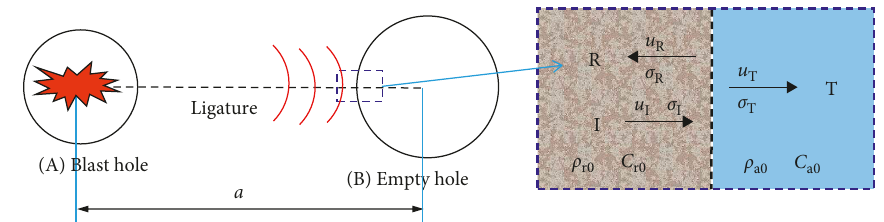
Figure 2: The free surface effect of an adjacent empty hole.